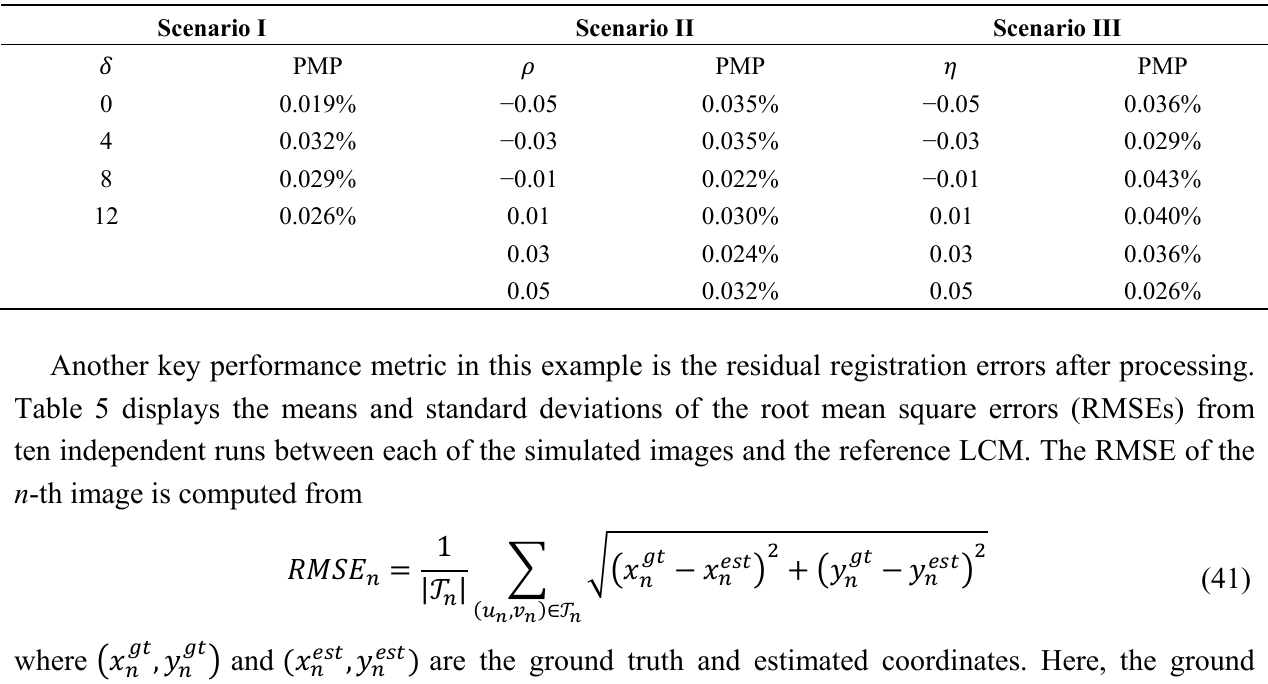
Table 4. The averaged percentages of mis-classified pixels as a function of the initial registration error for all